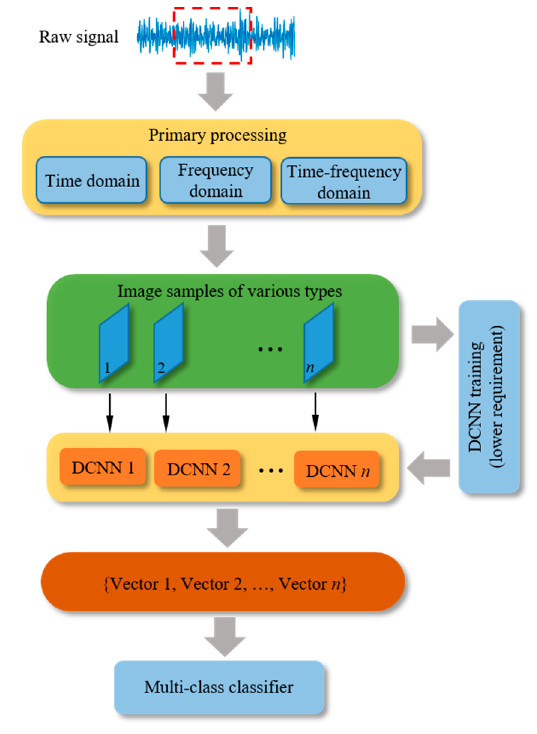
Figure 3. The proposed hybrid deep recognition scheme (hybrid Ada-DCNN).